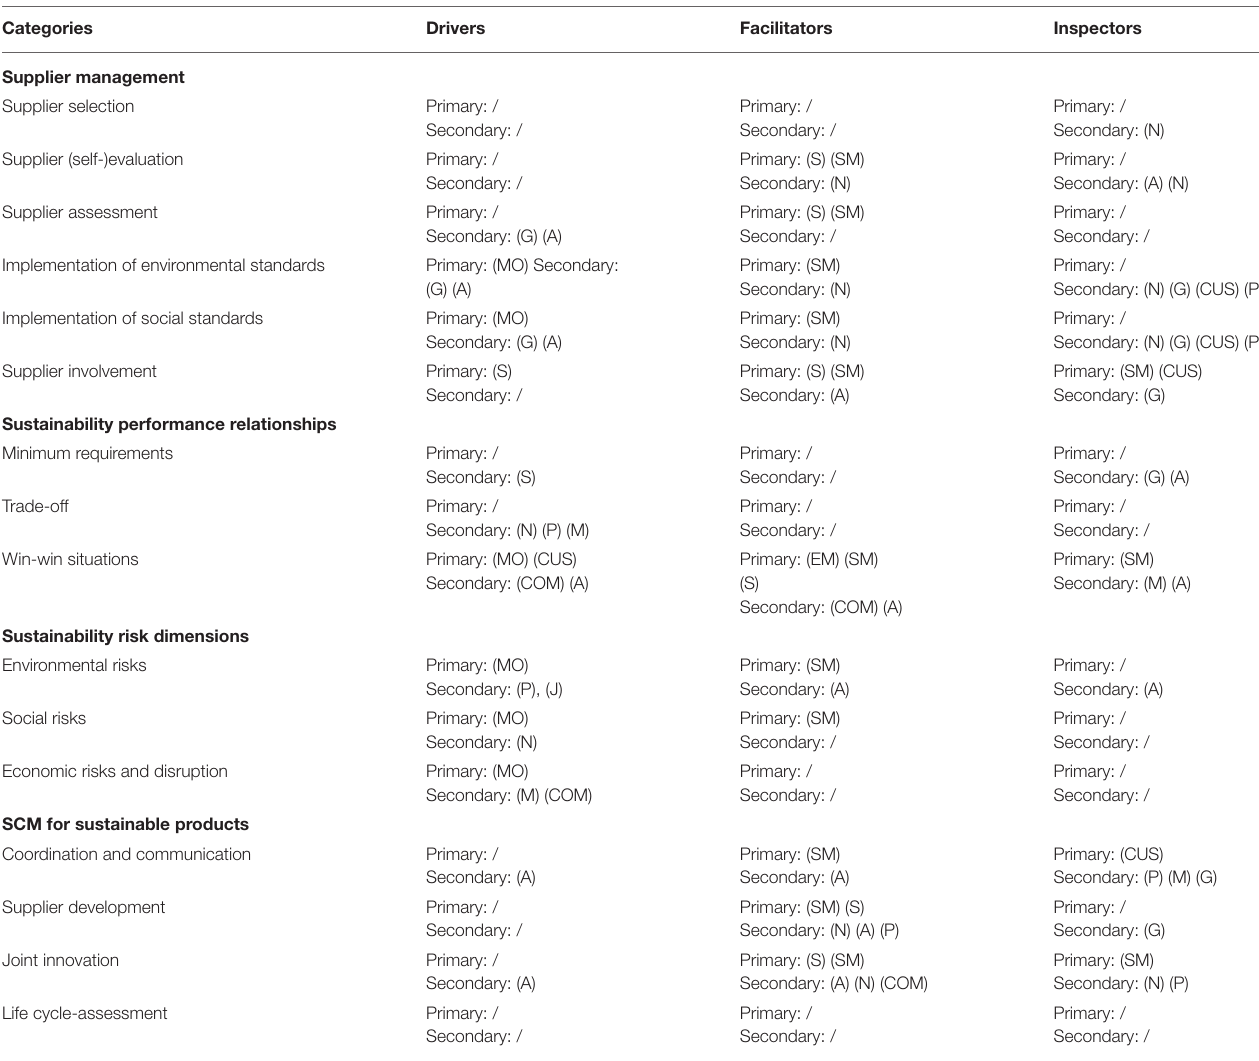
TABLE 4 | Cross-arrangement of SSCM categories and assigned stakeholder roles.